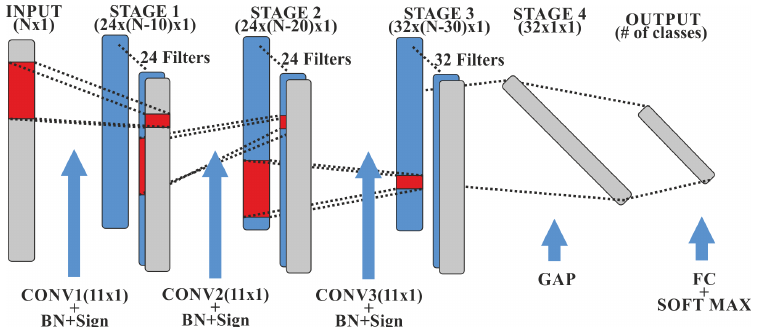
Figure 2. Model of the FCN. All the stages have been quantized with a 3Bit quantization scheme, taking values in the set {− 2, − 1,0,1,2 } . A 16-bits fixed point format is assumed as